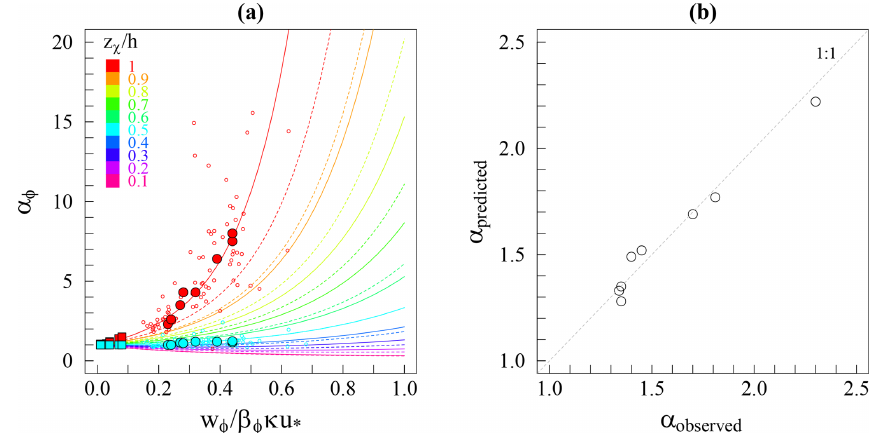
Figure 7. (a) Predicted and observed α φ i ratios as a function of the Rouse number. Filled circles and squares are the mean α φ values observed per site for the sand and fine mass fractions, respectively. Unfilled circles denote observed α s values. The red to pink rainbow set of solid lines correspond to the general model prediction (Eq. 17), and each represents 10% of the water height. Dashed lines are for the simplified model (Eq. 18). (b) Predicted vs. observed mean α ratios per site (i.e., total